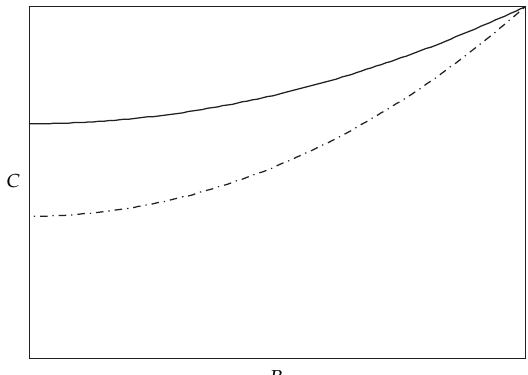
Figure 4: Qualitative sketch for the di ff usion reaction in spherical porous catalyst. The dashed line presents an initial guess C (cid:7) 1 (cid:8) φ 2 (cid:5) R 2 − 1 (cid:6) / 6, and the continued line presents the real solution.